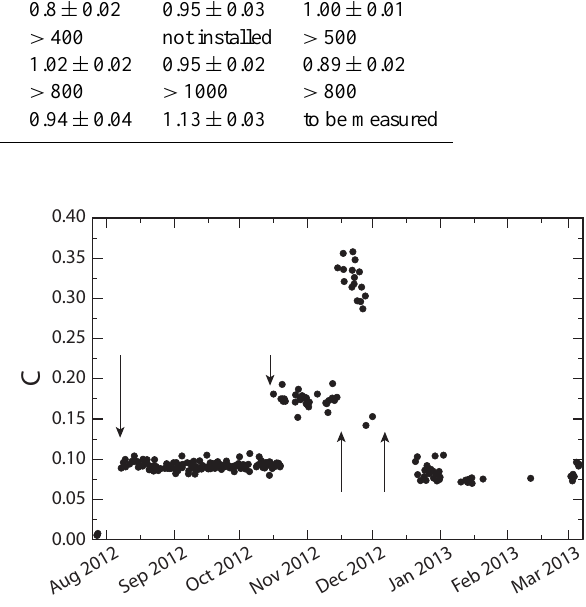
Figure 10. Time series of the routinely determined calibration con- stant C during measurements of Polly XT _IFT from August 2012 to April 2013. Arrows denote adjustments of the neutral-density fil- ters. The variability of C can attributed to the signal noise during the individual calibration measurements. Gaps in the time series are caused by measurement interruptions during bad